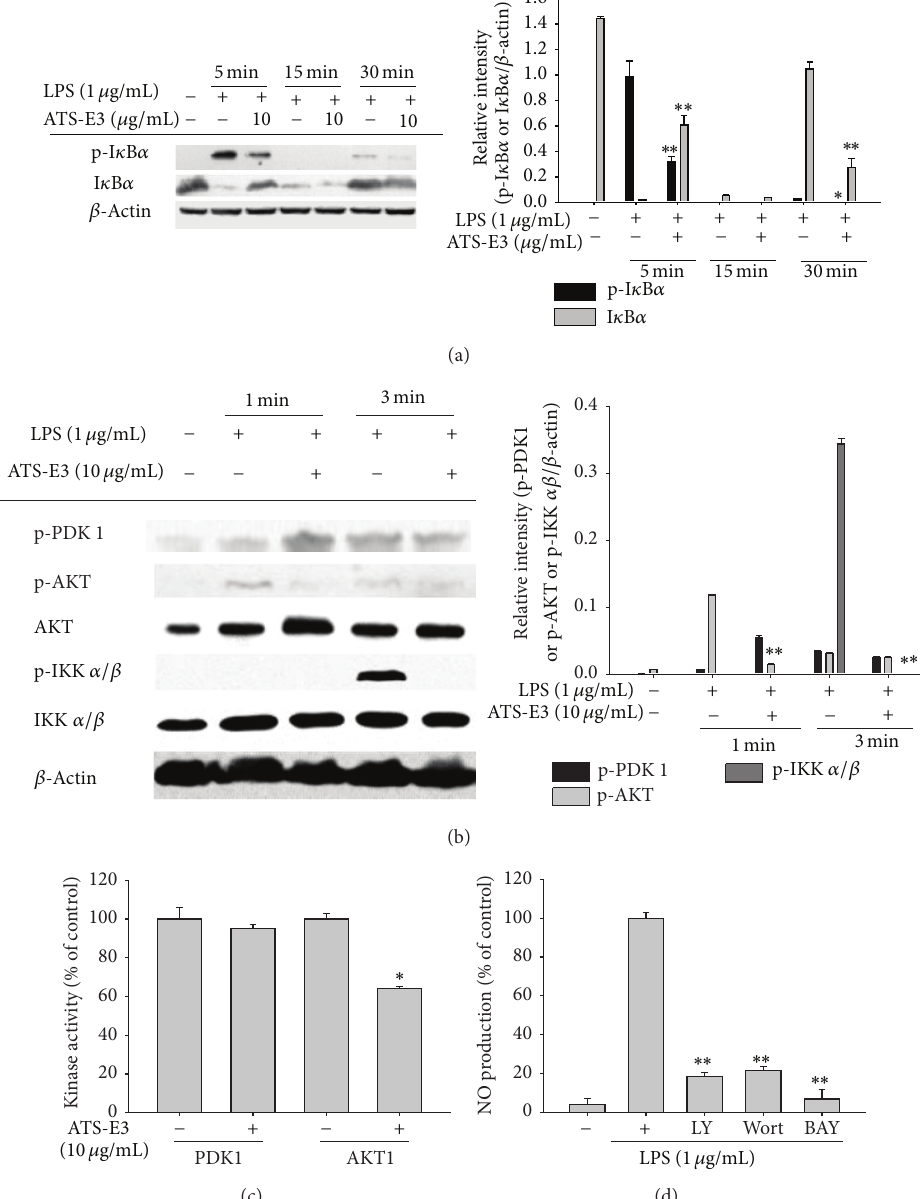
Figure 4: Effect of ATS-E3 on the activation of NF- 𝜅 B upstream signaling cascades. ((a) and (b)) Total and phosphoprotein levels of PDK1, AKT, IKK 𝛼 / 𝛽 , and 𝛽 -actin in whole cell lysates of LPS-treated RAW264.7 cells were determined by immunoblotting analysis. (c) Kinase activities of PDK1 and AKT1 were determined by a direct kinase assay using purified enzymes. The value of the control, which received vehicle treatment, was set as 100% activity for each enzyme (PDK1 or AKT1). (d) NO inhibitory activities of standard compounds (BAY11- 7082 (BAY), LY294002 (LY), and wortmannin (Wort)) were determined in RAW264.7 cells (1 × 10 6 cells/mL) treated with LPS (1 𝜇 g/mL)